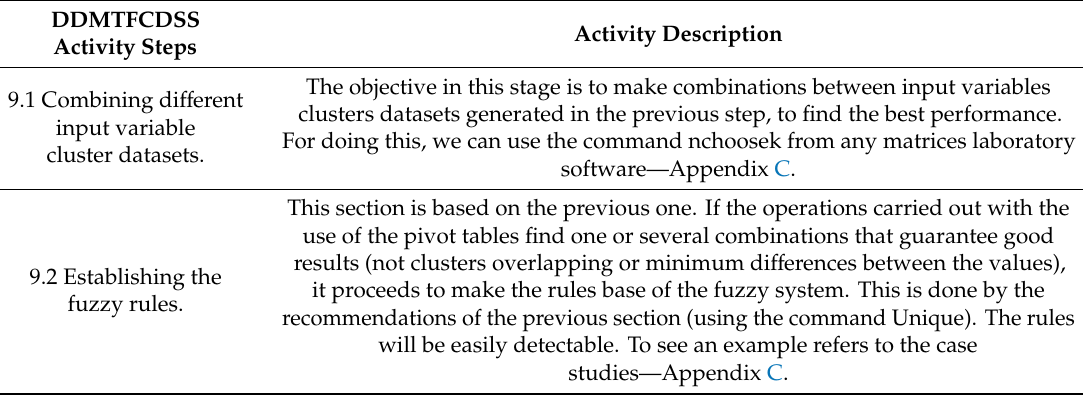
Table 6. Pivot tables substages and decision support systems’ implementation